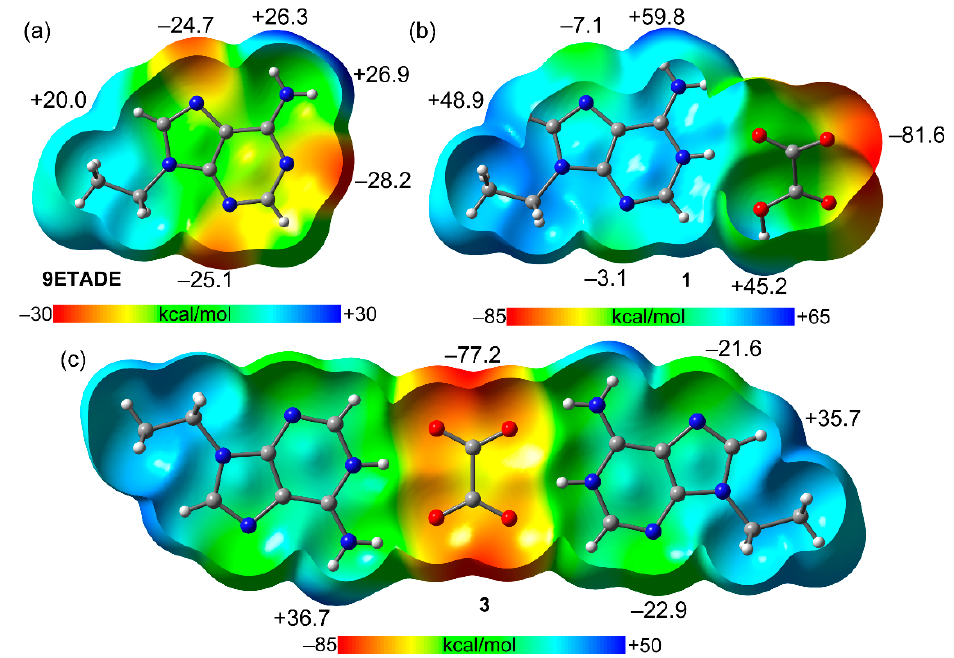
Figure 6. MEP surfaces (isovalue 0.01 a.u.) of 9ETADE ( a ), 9-ethyldeninimum hydrogenoxalate salt ( b ) and 9-ethyldeninimum oxalate salt ( c ) at the PBE0-D3/def2-TZVP level of theory. The energies at selected points of the surfaces are given in kcal/mol.